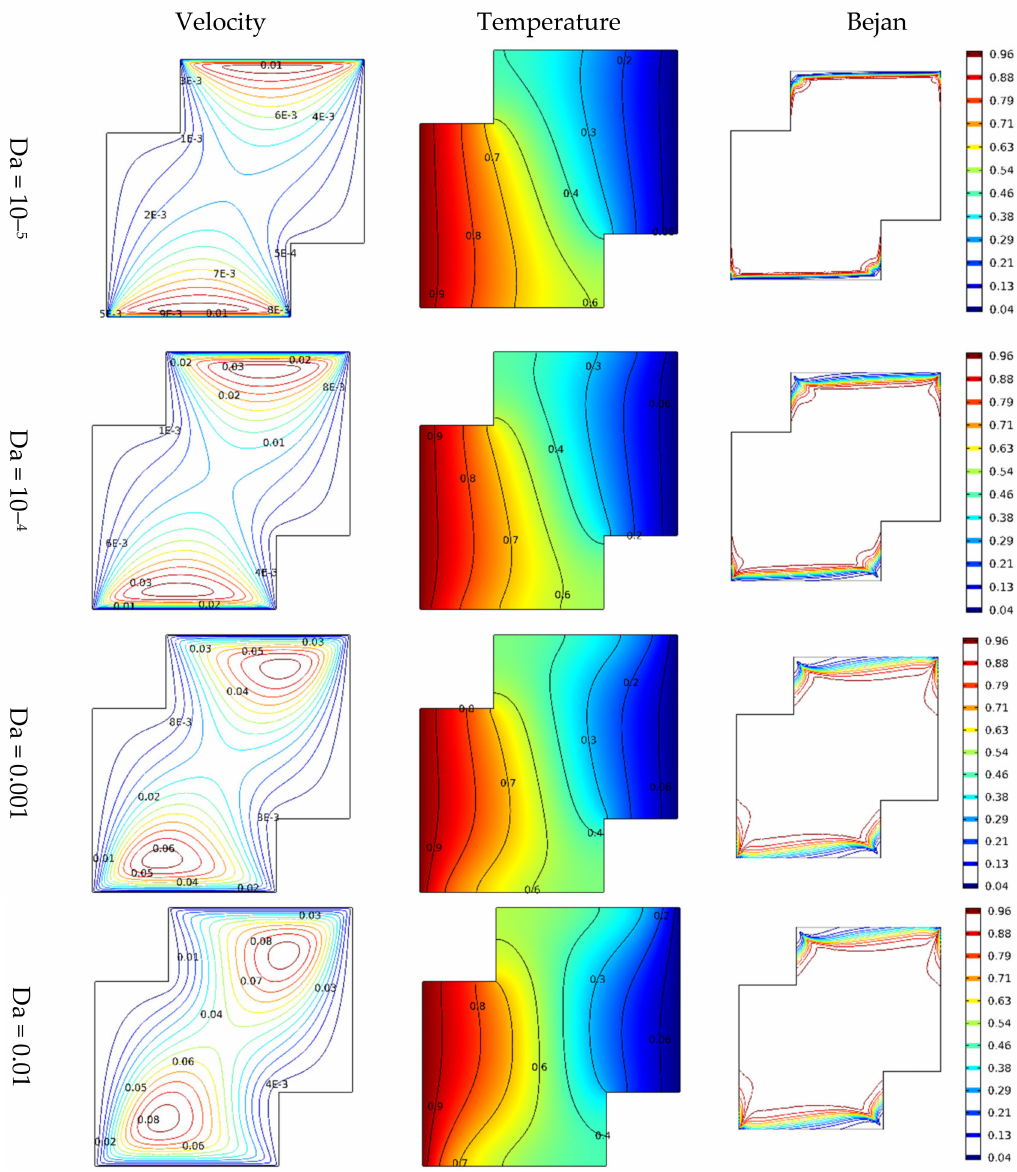
Figure 5. Variations in the velocity, temperature distribution, and entropy generation at different levels of Darcy number.